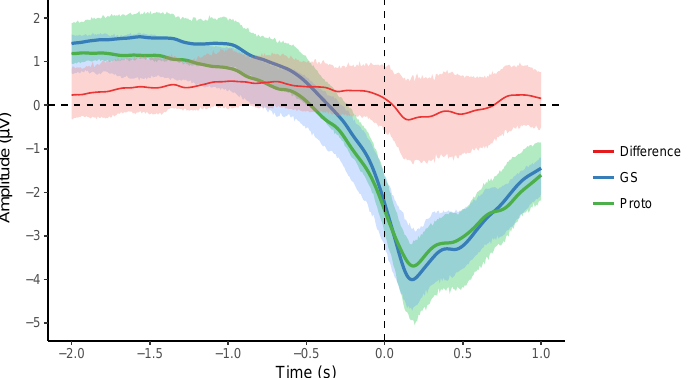
Figure 5. Grand averages and difference (GS-Proto) along with 95% confidence intervals for the averaged MRCPs ( n = 21). Time at 0 s corresponds to the movement